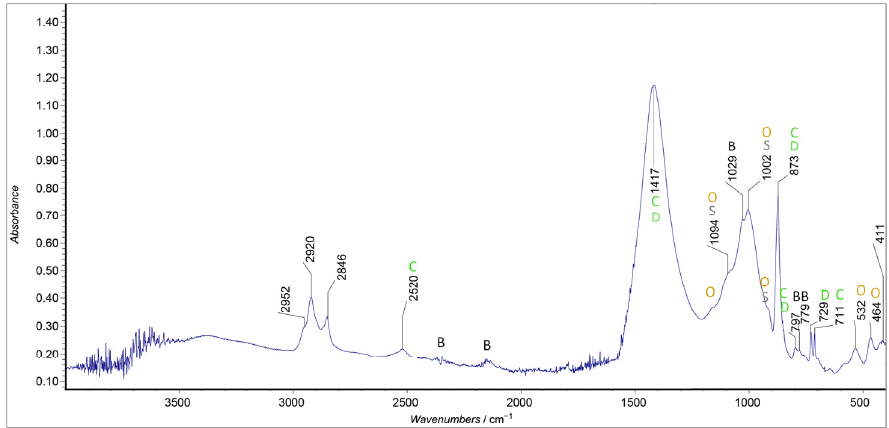
Figure 13. ATR-IR spectra for sample P4, ATR-corrected.